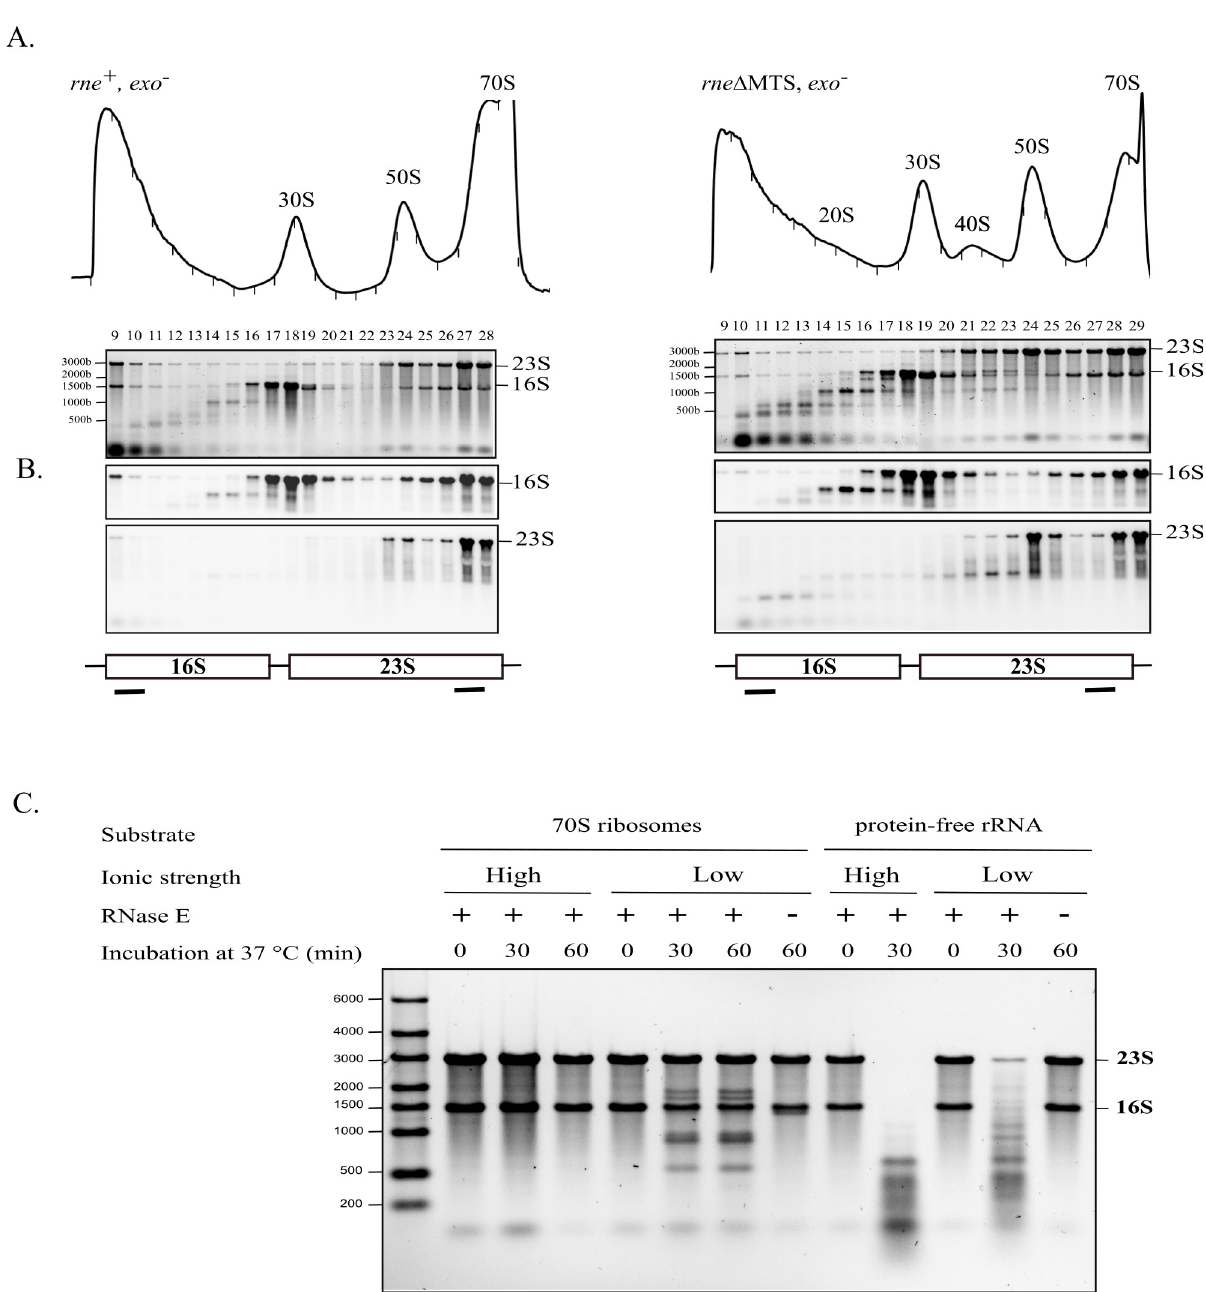
Fig 4. Identification of 16S and 23S rRNA fragments. (A) Equal volumes of cell lysates from the rne + , exo − (left) and rne Δ MTS, exo − (right) strains were separated by velocity sedimentation on 5% to 20% sucrose gradients. RNA from each fraction was separated by gel electrophoresis. (B) Northern blots with probes specific to the 5 0 end of 16S rRNA and the 3 0 end of 23S rRNA as indicated in the diagram at the bottom of each panel. (C) Degradation of rRNA in vitro. RNase E cleavage assays were performed with purified 70S ribosomes or protein-free rRNA. A representative experiment is presented. After incubation at the indicated temperature and times, RNA was extracted, separated on 1% agarose gels, and stained with SybrGreen. Each reaction contained 0.22 μ M 70S ribosome or rRNA and 0.3 μ M RNase E(1–598)-HIS6. Control lanes without RNase E ( − ) were also included. The position of the 23S and 16S rRNA are indicated to the right of the panel. Uncropped gels of Fig 4A and 4C and northern blots in Fig 4B can be found in S1 Raw Images.